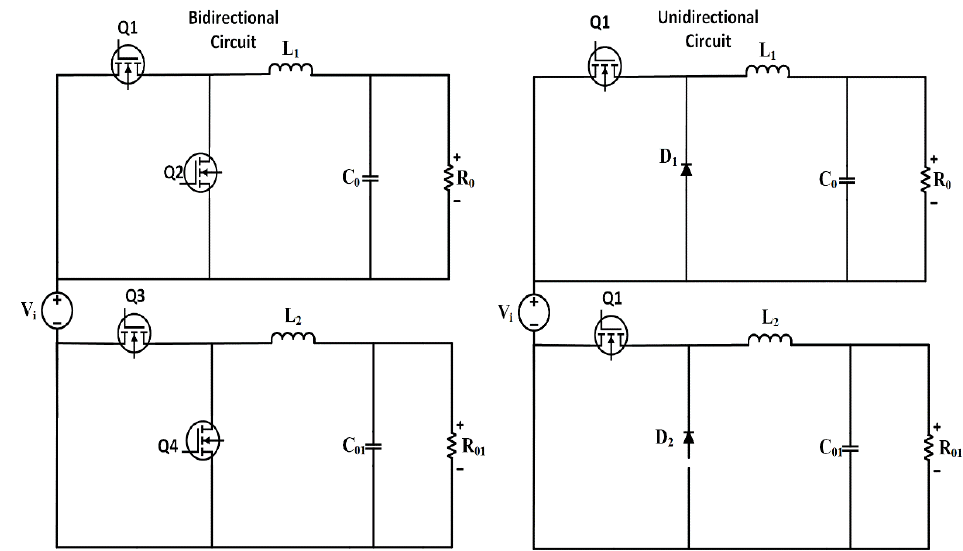
Figure 19. DC-DC buck converter with single input–dual output.